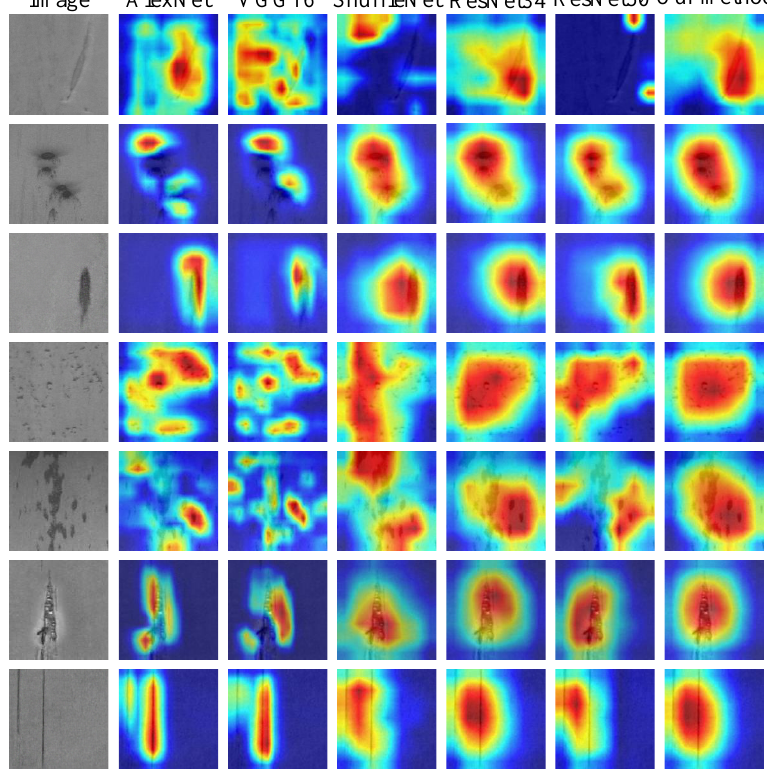
Figure 13. Visualization of feature extraction in the last convolution layer of each